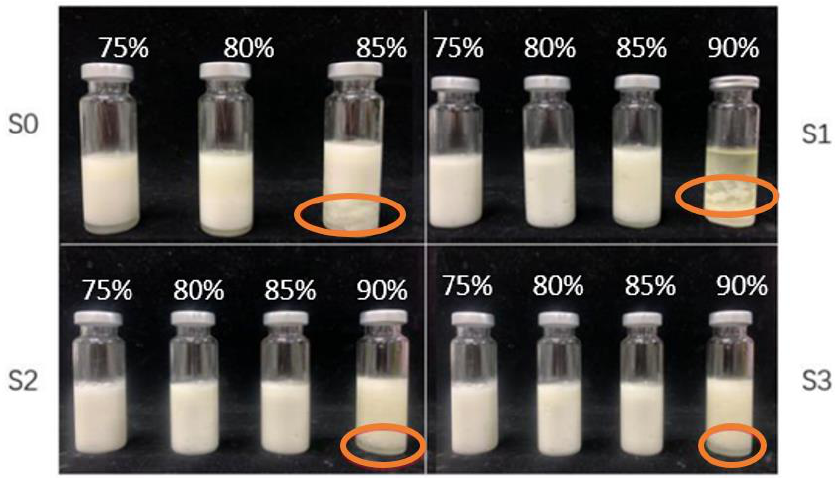
Figure 4. The appearance of the HIPEs prepared by EPI isolate cross-linked under different enzyme concentrations after 45 days at room temperature (25 °C). Flocculation phenomenon at orange circle mark.